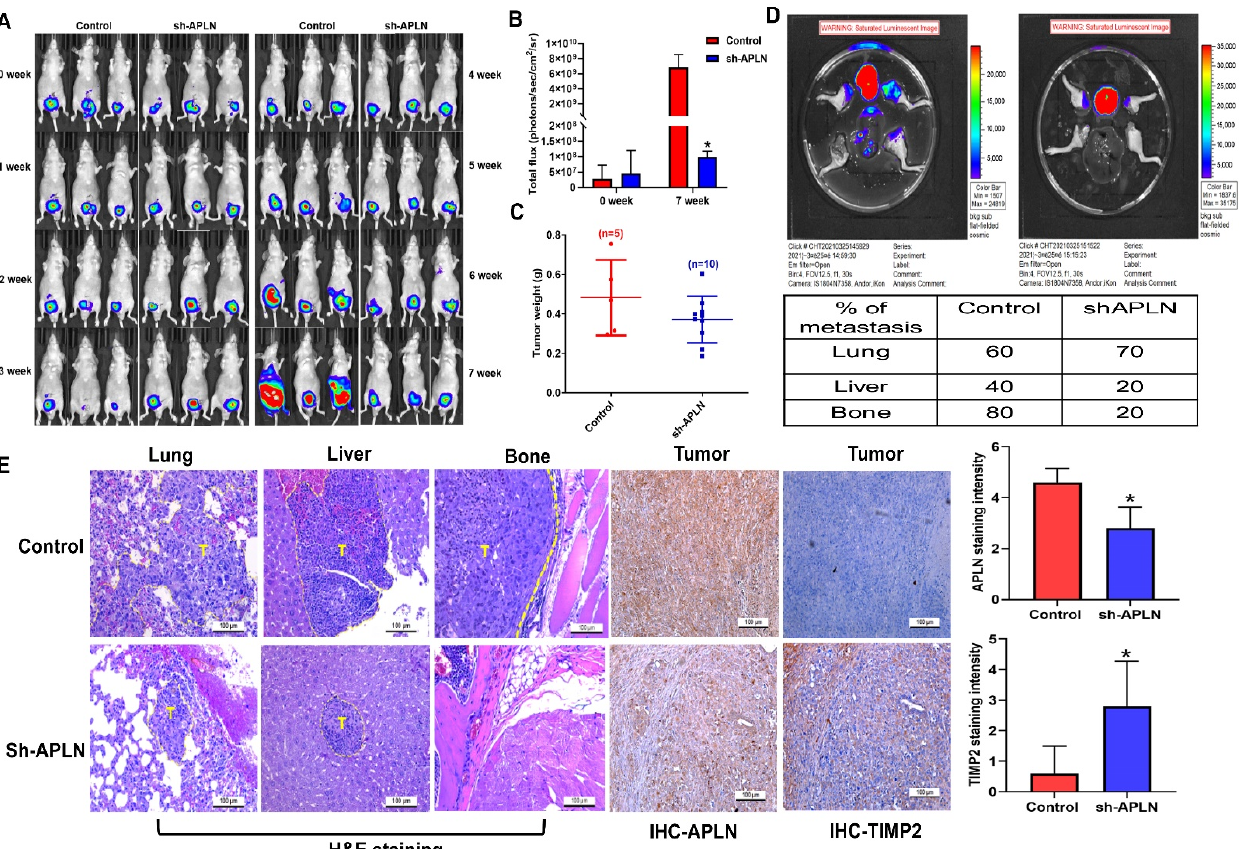
Figure 7. Apelin blockade inhibits prostate cancer metastasis in vivo. ( A – E ) PC3-Luc ( n = 6) or PC3/sh-APLN-Luc cells ( n = 6) were injected into the ventral prostates of SCID mice. Tumor growth, tumor metastasis to lungs, livers and legs were investigated by IVIS System. ( E ) Tissue specimens were stained with apelin or TIMP2 antibody and applied to IHC analysis. * p < 0.05 compared with the control group; Scale bar for all images is 100 μ m.